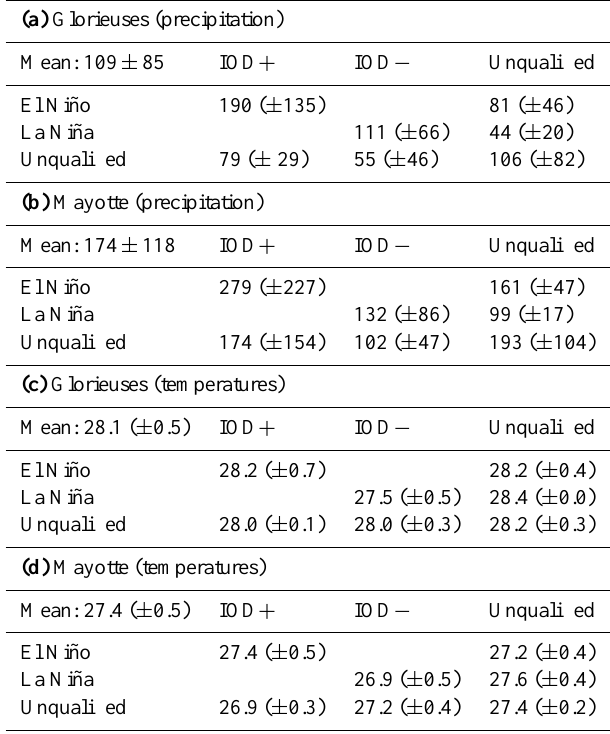
Table 3. Mean and SD of precipitation (mmmonth − 1 ) in December for (a) the Glorieuses and (b) Mayotte during the different phases of ENSO and IOD, and mean and SD of temperature ( ◦ C) for (c) the Glorieuses and (d) Mayotte during the different phases of ENSO and IOD.